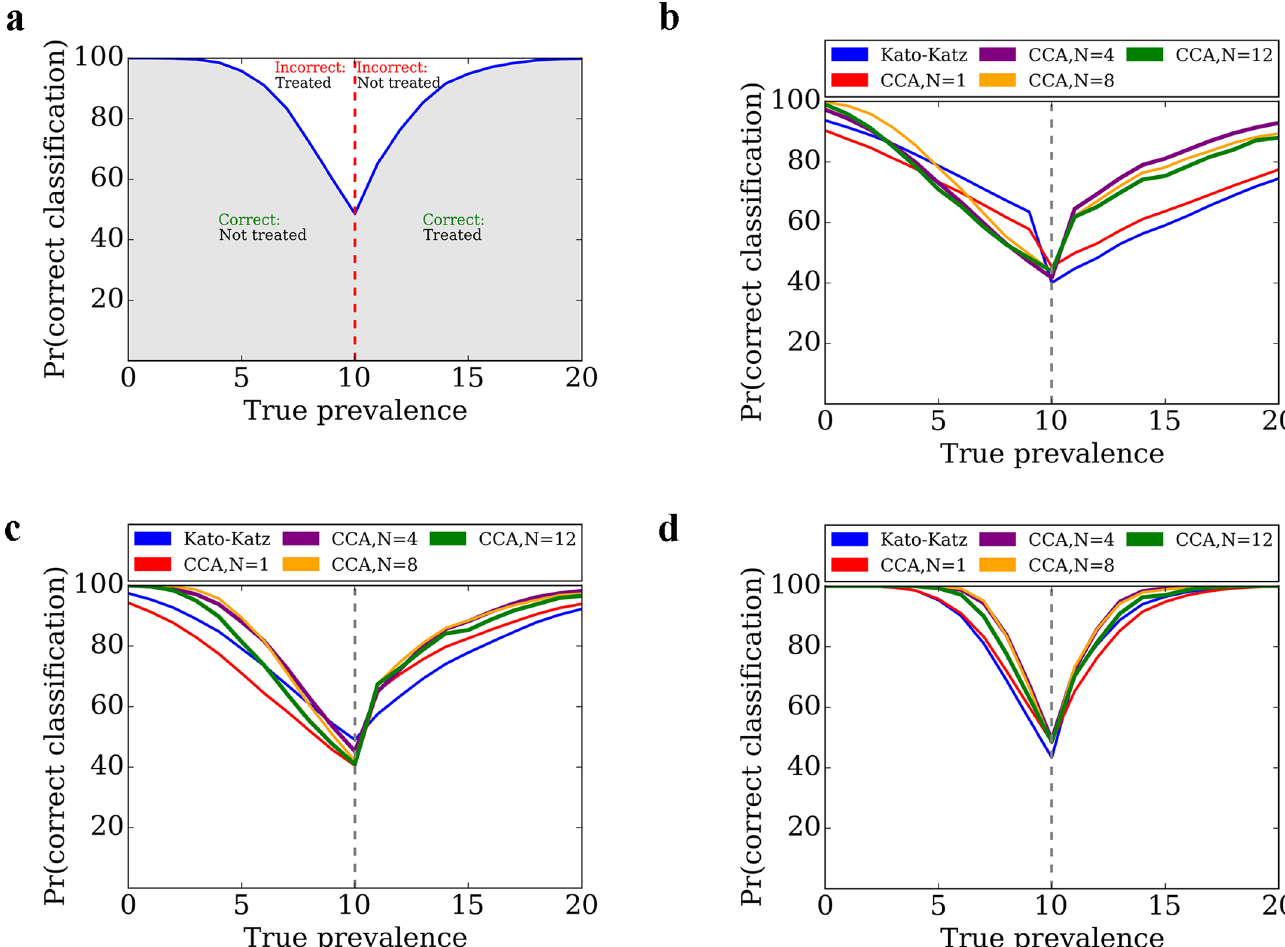
Fig 2. Operating characteristic curves for microsimulation analysis of urine pooling strategy to rapidly map the prevalence of schistosomiasis and inform preventive chemotherapy. Using primary data on urine pooling strategies (n = 4, 8, and 12 samples), we used a microsimulation to model the proportion (Pr) of correct binary classification around a prevalence threshold to indicate need for school-based preventive chemotherapy according to WHO (10% prevalence). The interpretation of the curves is provided in (a). The results are presented for: (b) 20 tests; (c) 50 tests; and (d) 250 tests. We compared traditional stool microscopy (duplicate Kato-Katz thick smears derived from one stool sample), single POC-CCA test, and the three urine pooling strategies (pool sizes of 4, 8, and 12) using the WHO 10% prevalence threshold. The strategies performed well within the center of a prevalence categorization, but poorly at the boundary between two prevalence categories. Increased number of tests resulted in lower classification